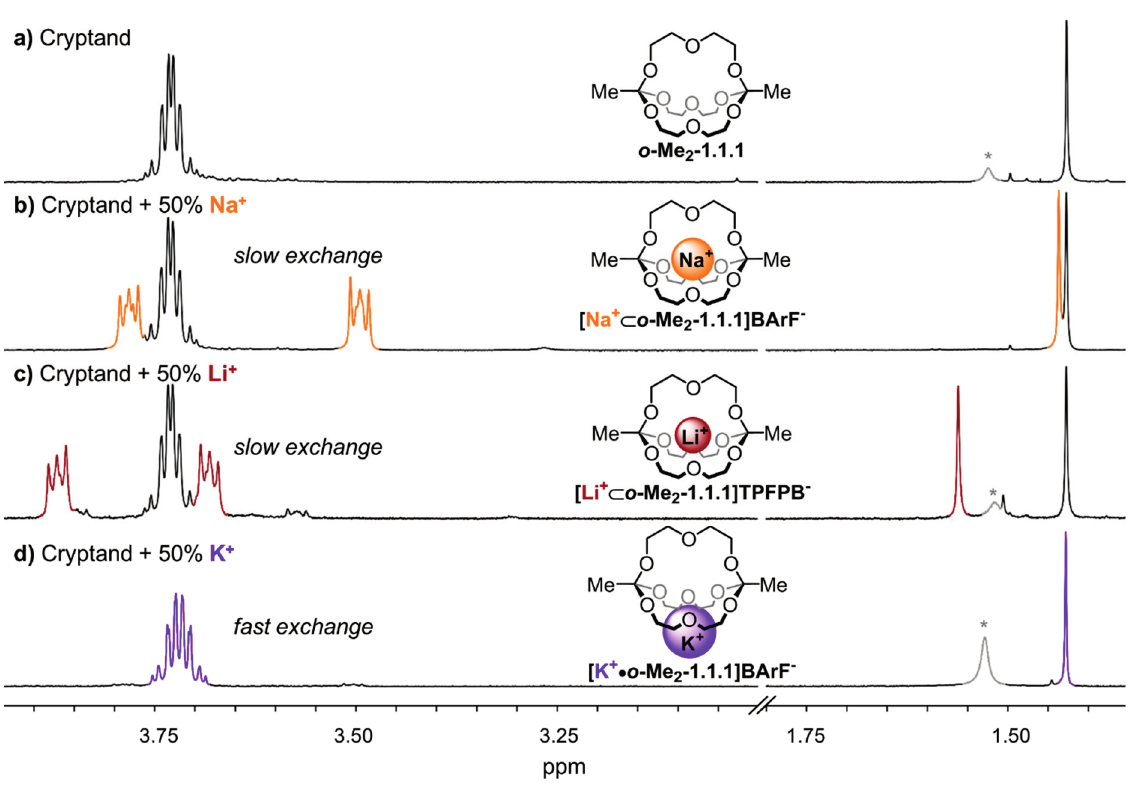
Figure 2. Partial 1 H NMR (400 MHz, 298 K, CDCl 3 ) stack plot; ( a ) only o -Me ( b ) 1:1 mixture of o -Me -1.1.1 and [Na + ⊂ o -Me 2 -1.1.1]TPFPB − ; and ( d ) 1:1 mixture of o -Me and [Li + ⊂ o -Me 2 BArF − . * : Peaks in grey color correspond to